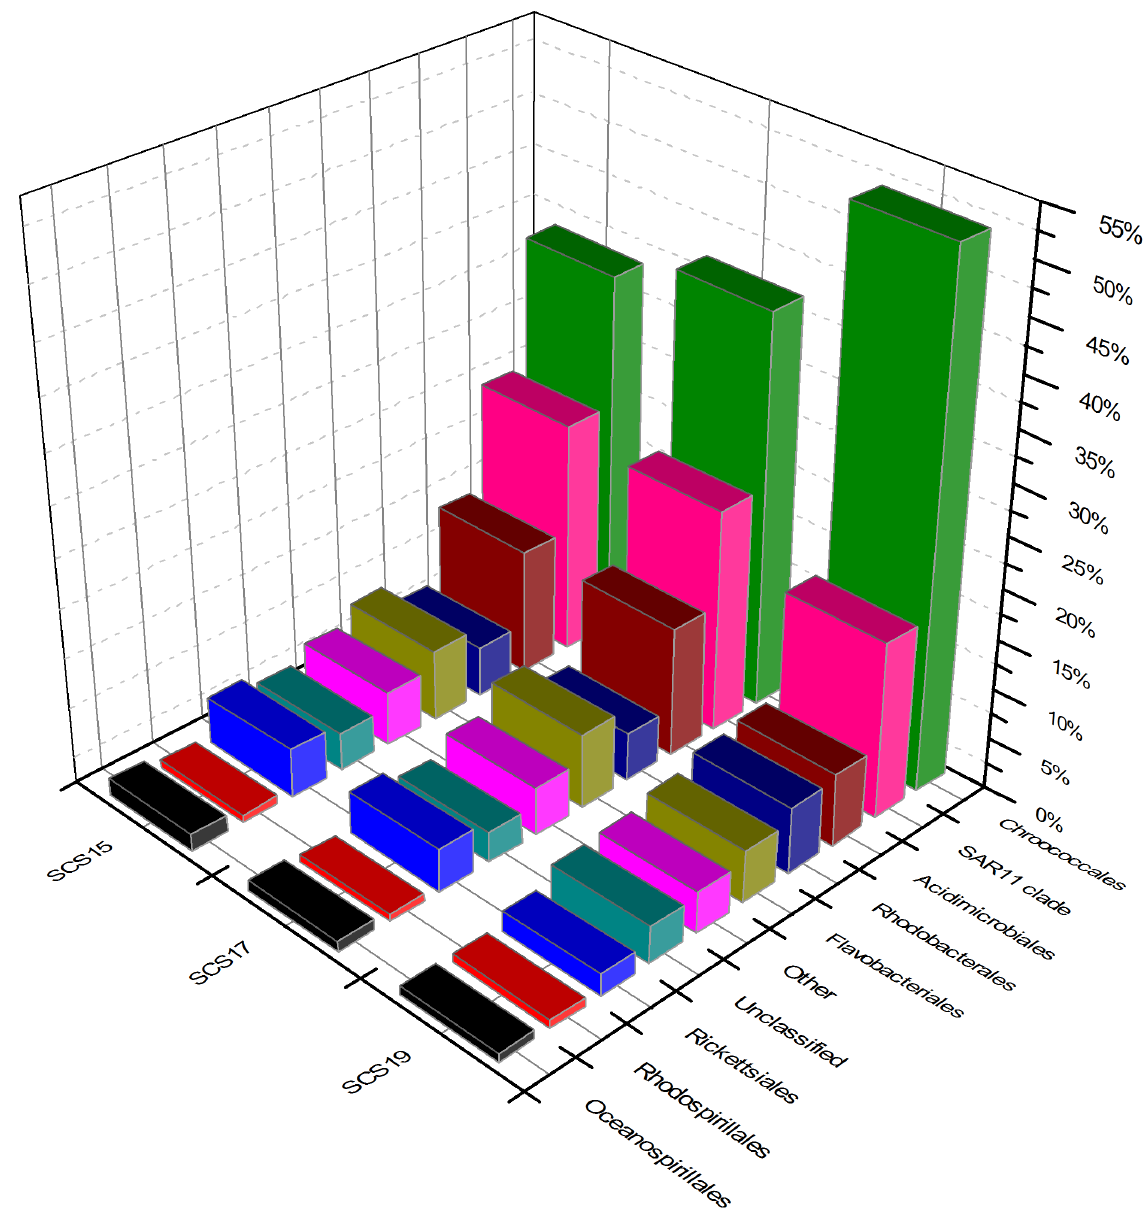
Figure 3. Bacterial compositions of the different communities in the nSCS.